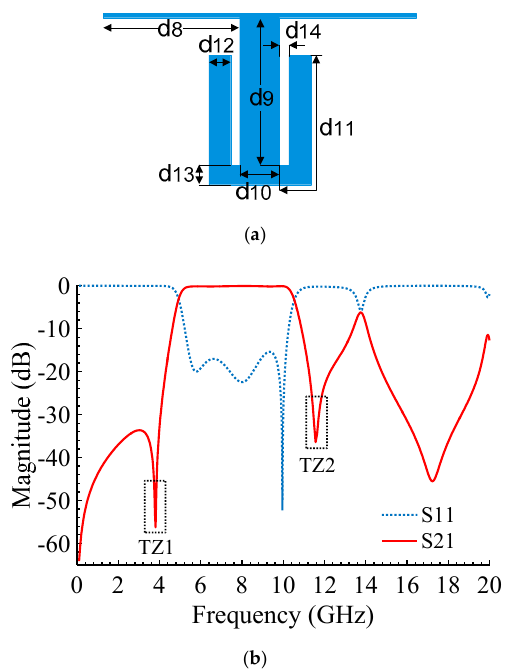
Figure 2. Single-band bandpass filter (BPF): ( a ) Layout, d8 = 7, d9 = 7.5, d10 = 2, d11 = 8.2, d12 = 1.1, d13 = 1, d14 = 0.5 (unit: Mm), ( b ) EM simulation.